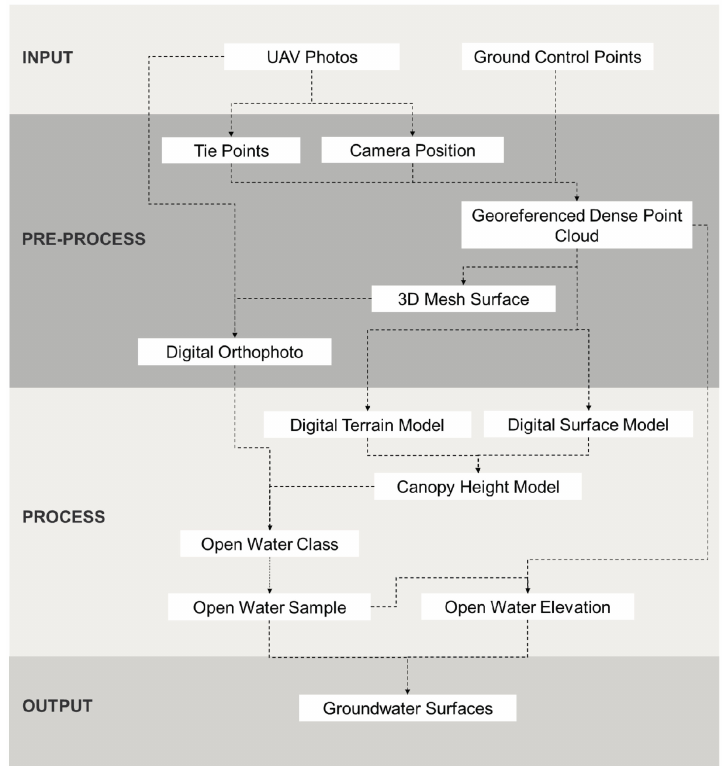
Figure 2. Workflow for mapping groundwater using unmanned aerial vehicle (UAV) orthophotography and photogrammetric point